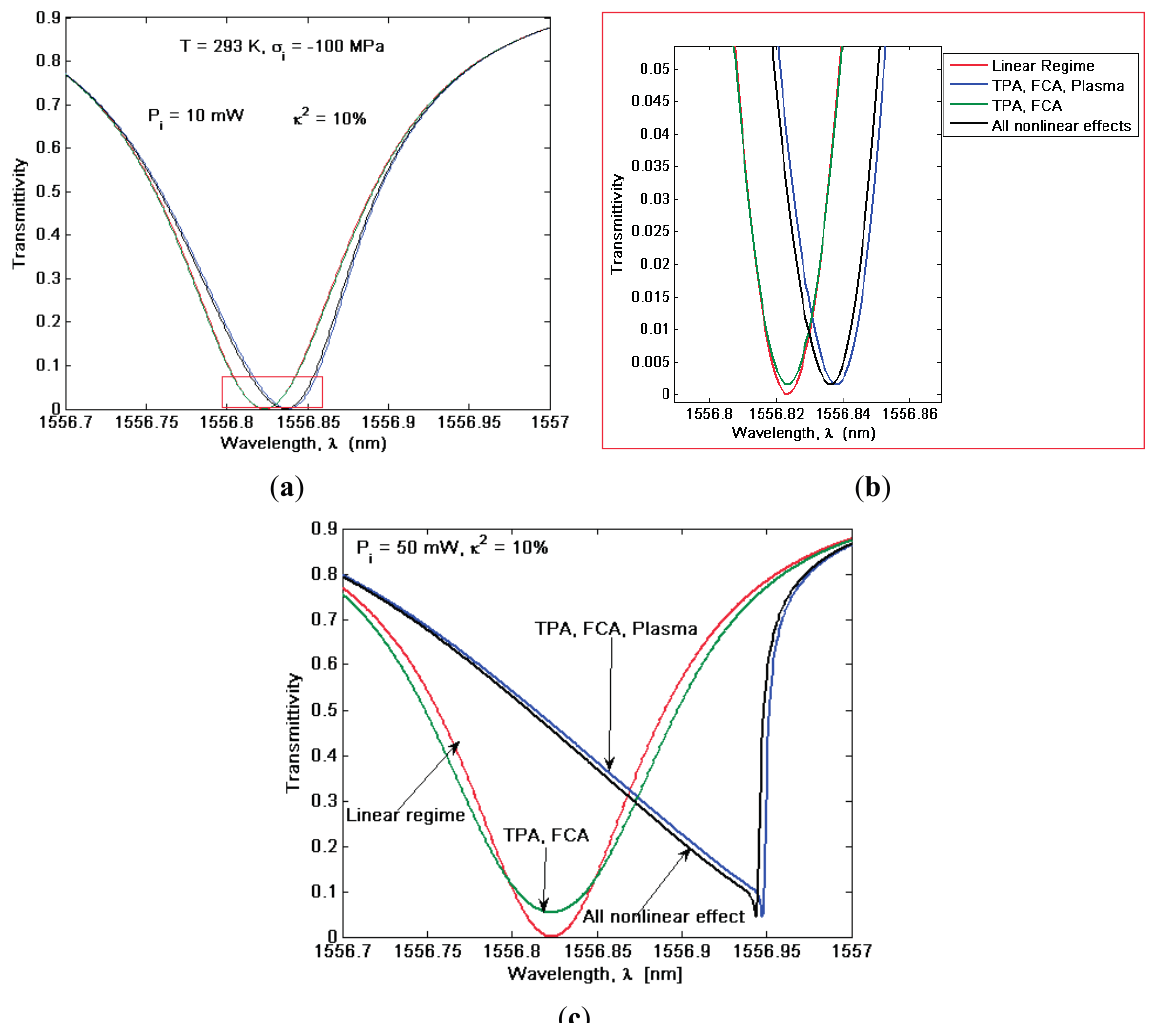
Figure 6. Transmittivity versus wavelength for different nonlinear effects: ( a ) input